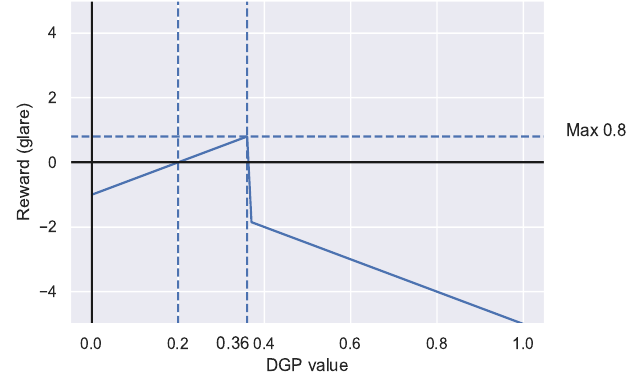
Figure 3. Reward function based on glare (DGP values).